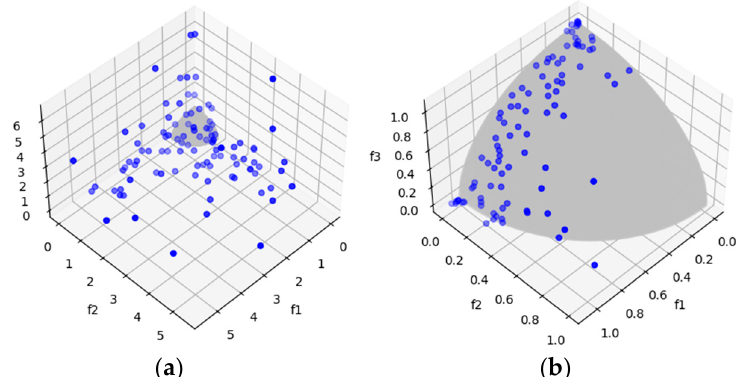
Figure 14. The plots of the approximate PFs with the highest HV value against real PF. ( a ) UF7 approximate PF using MOSA/D-CGO; ( b ) UF7 approximate PF using MOSA/D-DE.